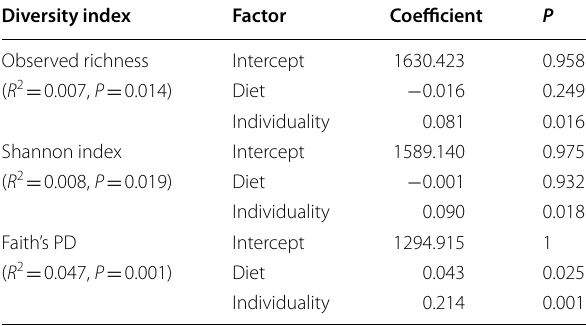
Table 1 Summary of the results on multiple regression on distance matrices (MRM) on the effect of diet and individuality on gut microbe alpha diversity indices